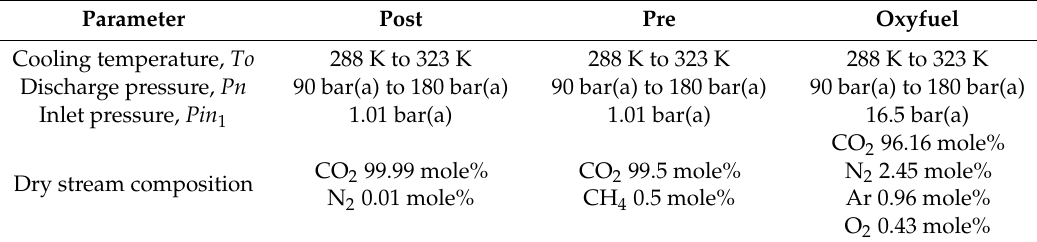
Table 2. Summary of compressor modeling